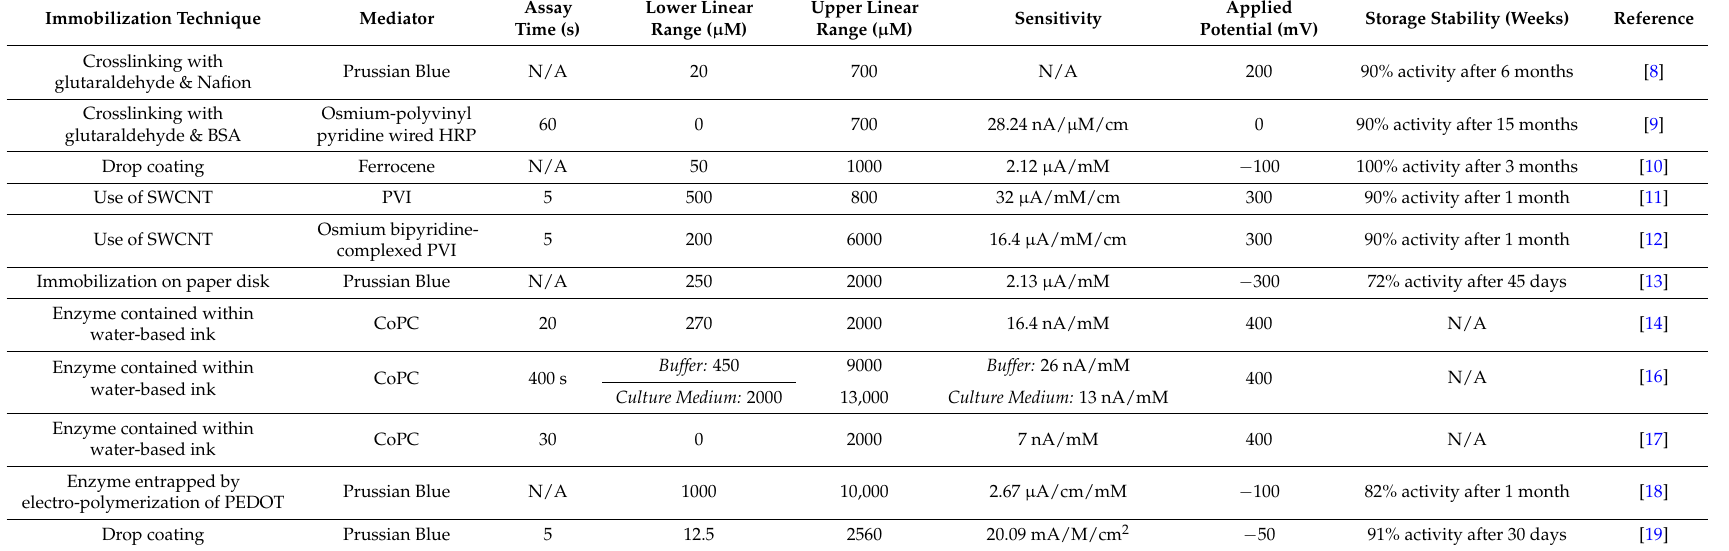
Table 1. Reports of screen-printed carbon electrodes incorporating glucose oxidase for glucose